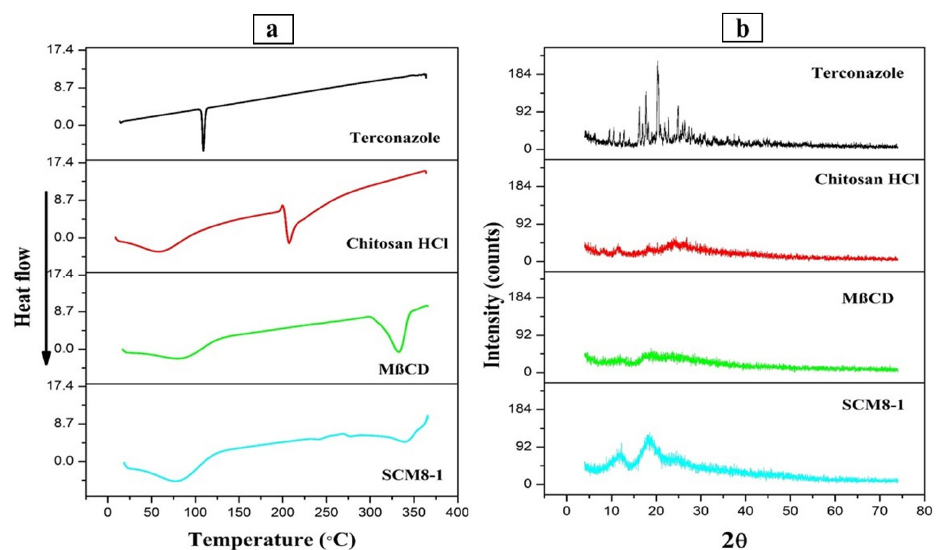
Figure 5. ( a ) DSC curves and ( b ) X–ray diffractions for terconazole, chitosan HCl, M β CD and the selected formulation SCM8–1.